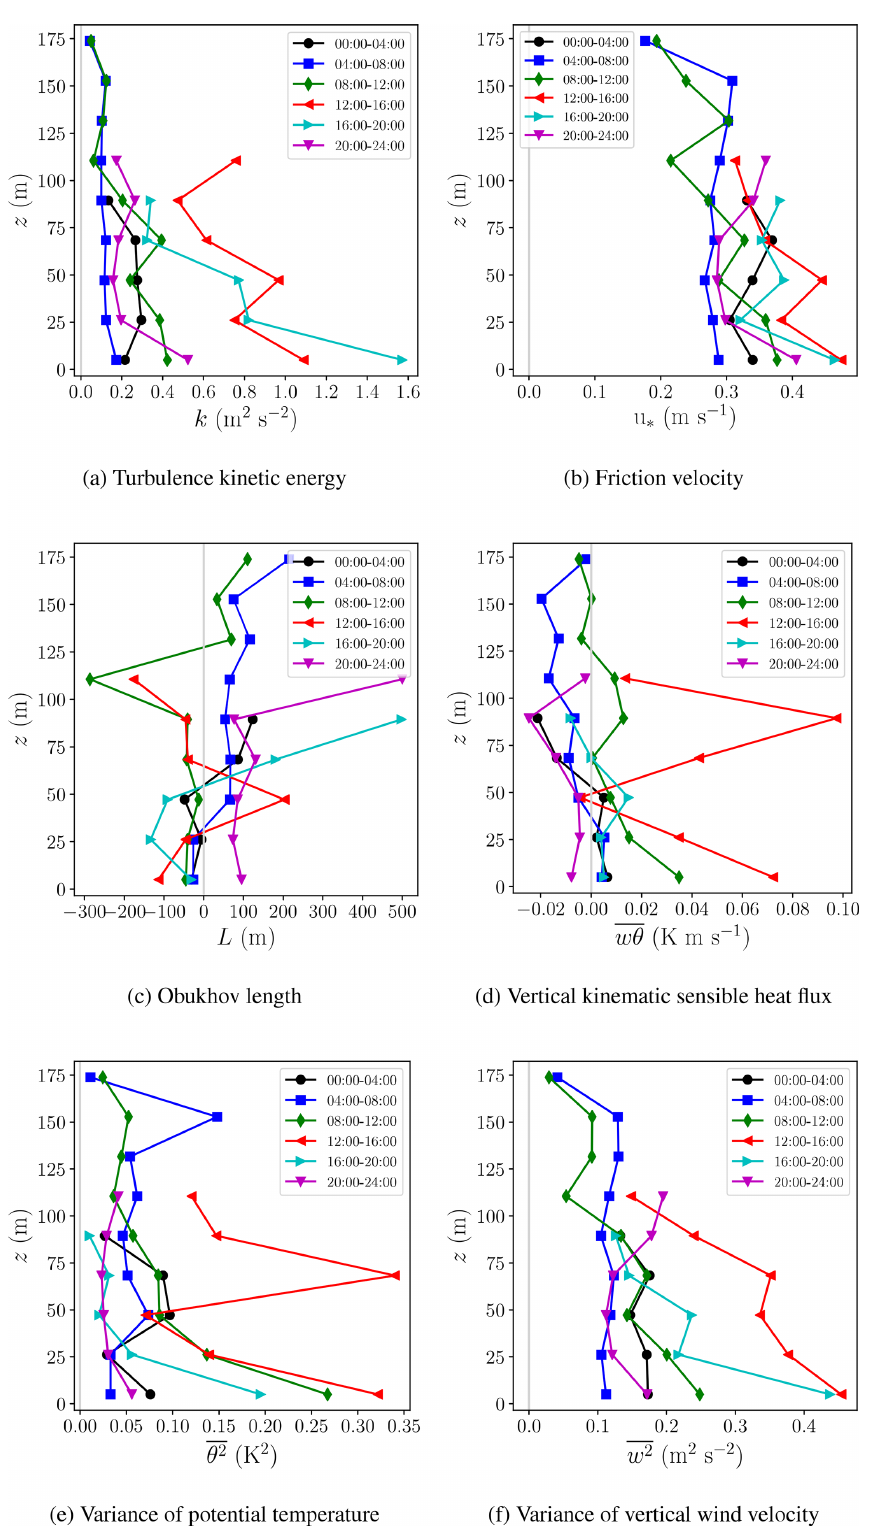
Figure 8. Vertical profiles of different turbulence statistics for different diurnal time periods (4h intervals) of the day; times are in LDT.